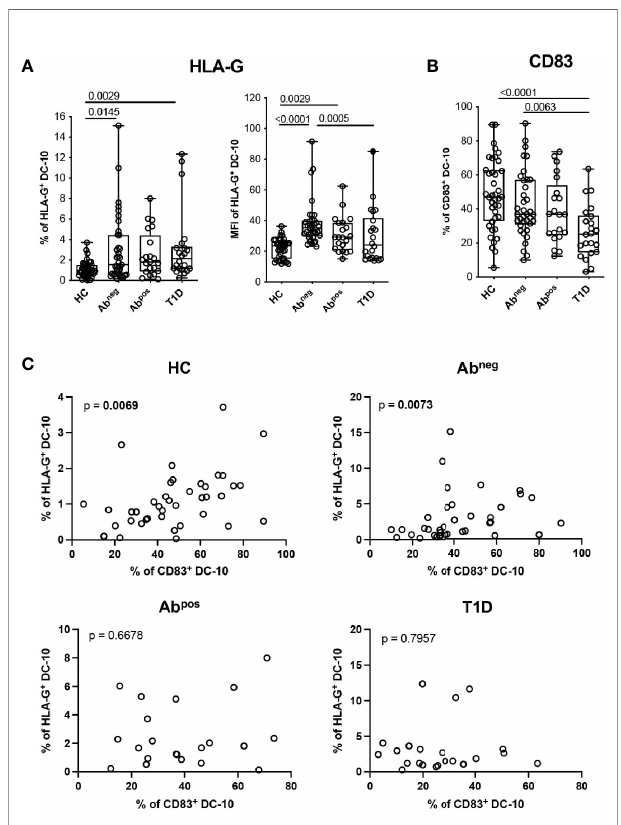
FIGURE 4 | DC-10 from type 1 diabetes (T1D) patients and fi rst-degree relative (FDR) subjects show an altered phenotype. DC-10 were identi fi ed as CD11c + CD14 + CD16 + CD141 + CD163 + , cells and the expression levels of the indicated markers were measured by multiparametric fl ow cytometry in the peripheral blood of pediatric healthy donors (HCs; n = 40), age-matched fi rst-degree relatives of T1D patients without (Ab neg , n = 37) or with (Ab pos , n = 21) autoantibodies, and pediatric T1D patients (T1D, n = 22). (A) Percentages of HLA-G-expressing cells (left panel) and HLA-G MFI (right panel) on DC-10. (B) Percentages of CD83 + DC-10. Each dot represents a single donor, and the black dot in the T1D group indicates a donor identi fi ed as outlier by corresponding linear mixed-effects (LME) model used for the comparing groups; lines indicate medians, and whiskers are minimum and maximum levels. For each set of data, post-hoc analysis of the LME model with the R package phia was performed for testing the difference between groups. Numbers indicate statistically signi fi cant Bonferroni ’ s adjusted p-values. The p-values of all comparisons are reported in Supplementary Table S2 . In the LME analysis, the % of HLA-G + DC-10 and MFI of HLA-G + DC-10 were used in natural logarithmic scale, while the % of CD83 + DC-10 were used in square root scale in order to meet the assumptions of the model. (C) Analysis of dependency between the expression of HLA-G and CD83 in DC-10 in the indicated cohorts of donors are shown. Data distribution and p-values are shown for each analysis. Statistically signi fi cant p-values are indicated in bold. In the analysis, the response variable (% of HLA-G + DC-10) was used in square root scale for the HC and Ab pos groups, and in natural logarithmic scale, for the Ab neg and T1D groups in order to meet the assumptions of the